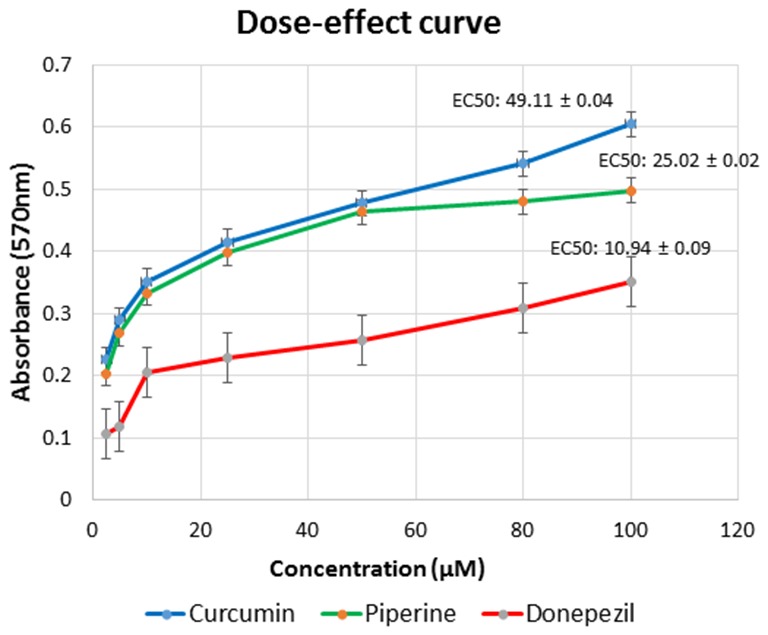
Dose–response relationships for curcumin, piperine, and donepezil used singularly in various concentration gradients from 2.5 μM to 100 μM. Each curve represents the increase in cell viability as a function of the dose. Effective concentration (EC) was calculated using GraphPad Prism.